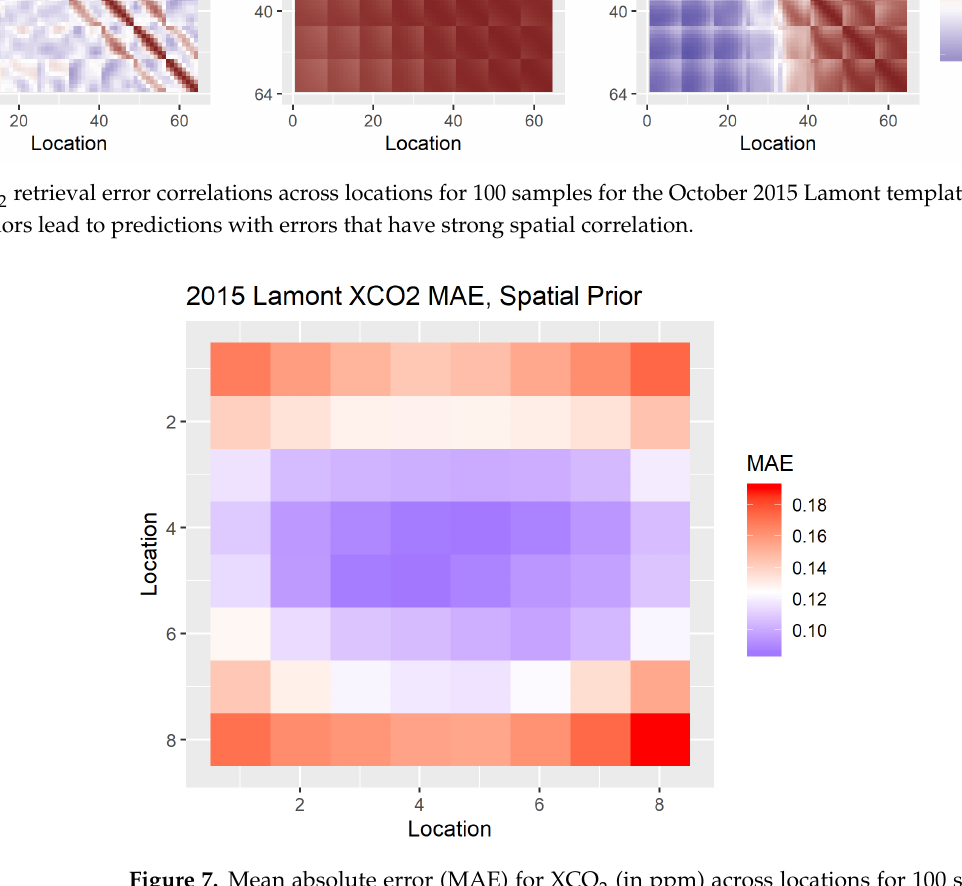
(in ppm) across locations for 100 samples for the 2